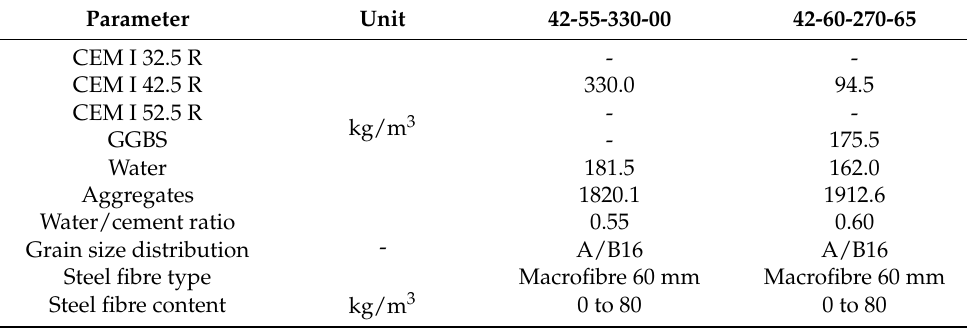
Table A7. Concrete mix designs for the multiple parameter variation—part 2.